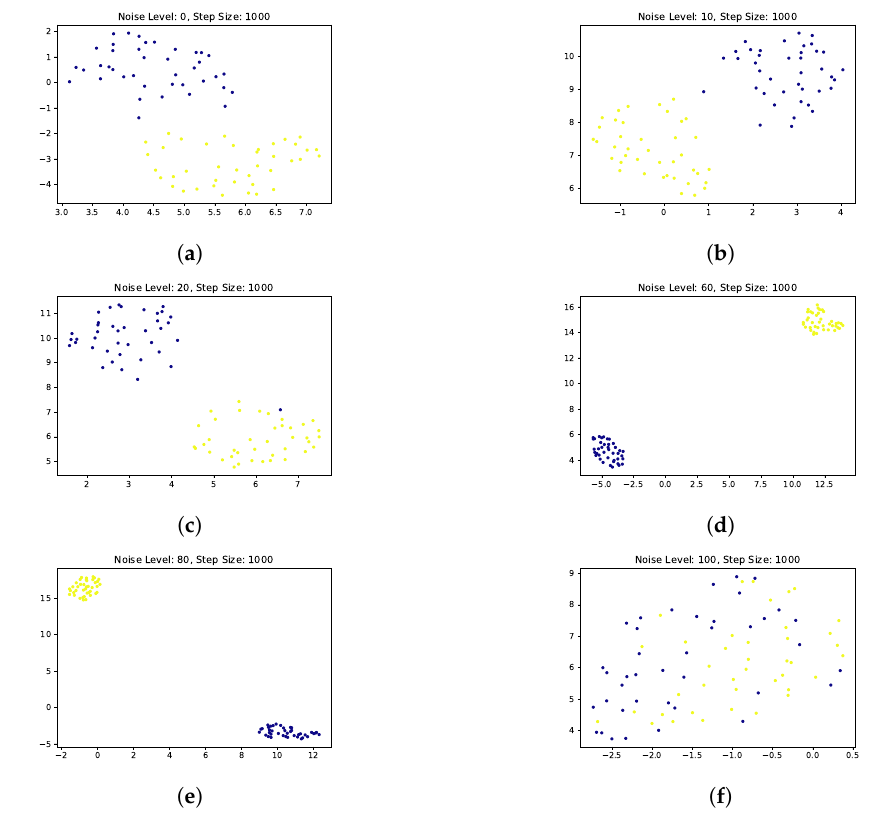
Figure 14. Examples of embeddings in different noise levels (( a ) 0; ( b ) 10; ( c ) 20; ( d ) 600; ( e ) 80; ( f ) 100); 1000 time steps used for single data point (Dataset